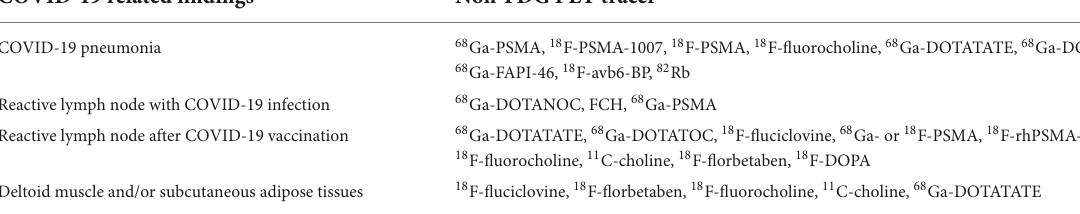
TABLE 2 COVID-19 related findings with non-FDG PET